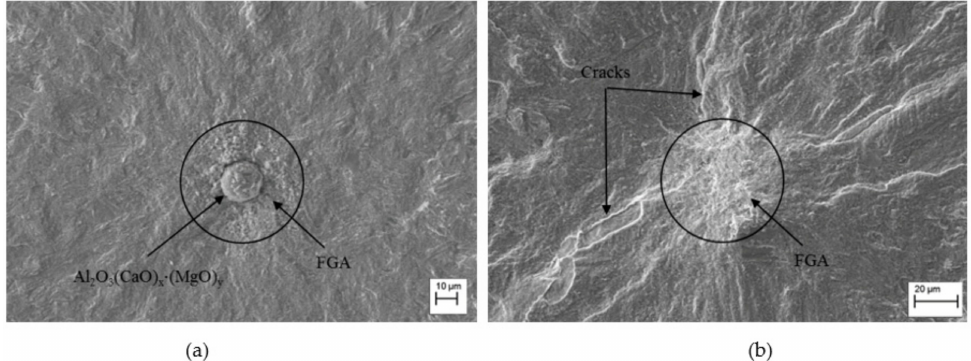
Figure 11. Fatigue crack initiation sites in 16MnCrV7 7: ( a ) internal crack initiation at non-metallic inclusion (tempered martensite, 43HRC, σ a = 625 MPa, N = 0.9 × 10 8 ), and ( b ) internal crack initiation at a grain boundary triple point (presumed) (37HRC, σ a = 400 MPa, N = 8.7 × 10 8 ).